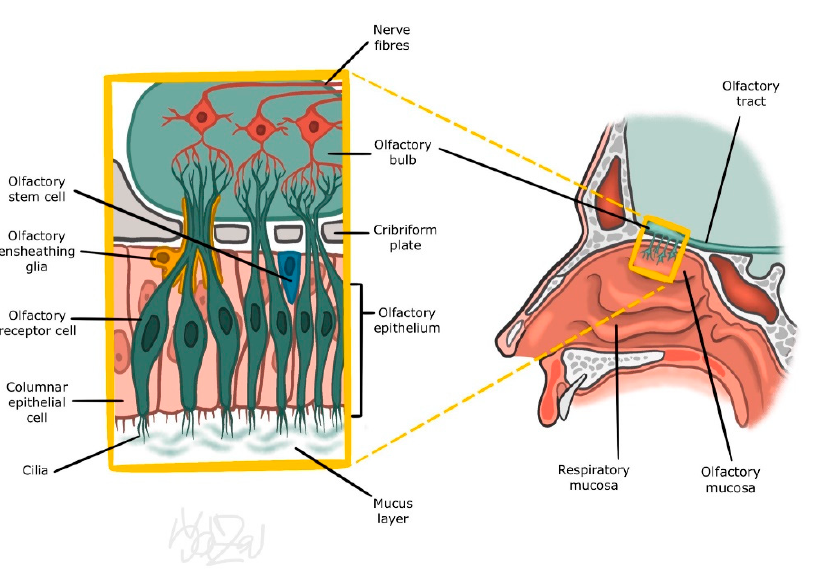
Figure 1. Olfactory epithelium (from co-author’s